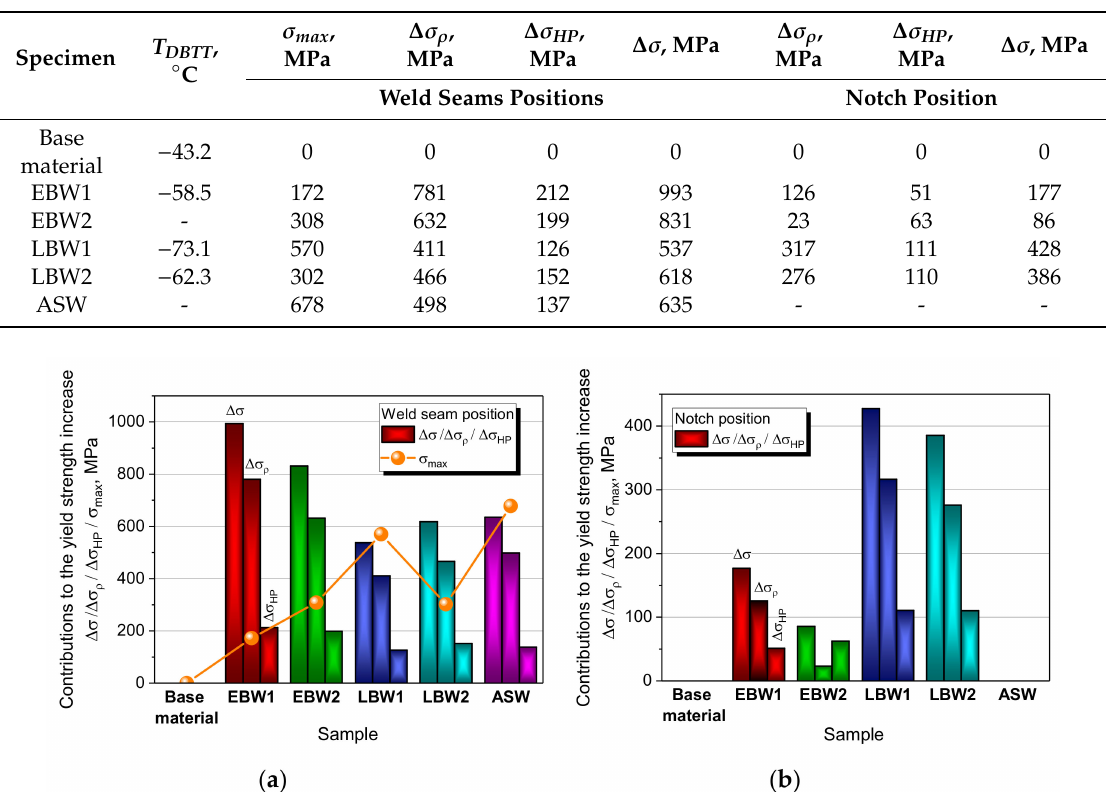
Table 3. Ductile-brittle transition temperature T DBTT , maximal value of residual stress σ max , yield strength increase due to dislocation ∆ σ ρ , and grain boundary ∆ σ HP strengthening, total yield strength increase ∆ σ = ∆ σ ρ + ∆ σ HP estimated at weld seams positions and at the notch positions.